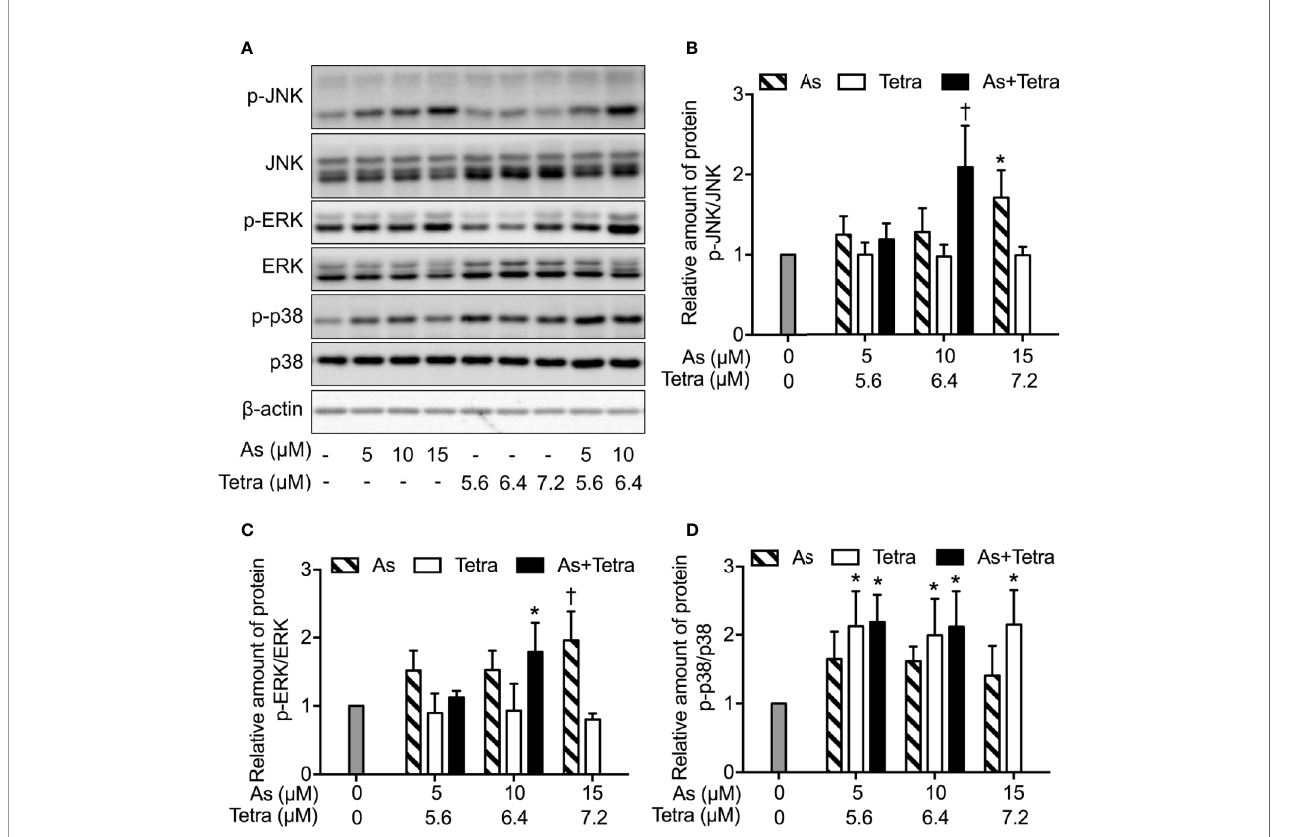
FIGURE 6 | MAPK activation in MDA-MB-231 cells treated with As III and Tetra, alone or in combination. (A – D) Following treatment for 48 h with the indicated concentrations of As III and Tetra, alone or in combination, the expression pro fi les of both phosphorylated and total forms of JNK, ERK, and p38 were analyzed using western blotting. Representative images of the expression pro fi le of each protein are shown from three independent experiments. The relative expression levels were expressed as the ratios between the phosphorylated active form and total form of each target protein expression levels, and compared with those of untreated control group, respectively. Results are shown as the means ± SD from three independent experiments. p-JNK, p-ERK, and p-p38 represent phospho-JNK, phospho-ERK, and phospho-p38, the respective phosphorylated active form of each MAPK. *p<0.05, † p<0.01, vs. control. As, As III ; Tetra, tetrandrine. Since enough cells cannot be collected in the group treated with 15 m M As III in combination with 7.2 m M Tetra due to its strong cytotoxicity, western blot analyses were not